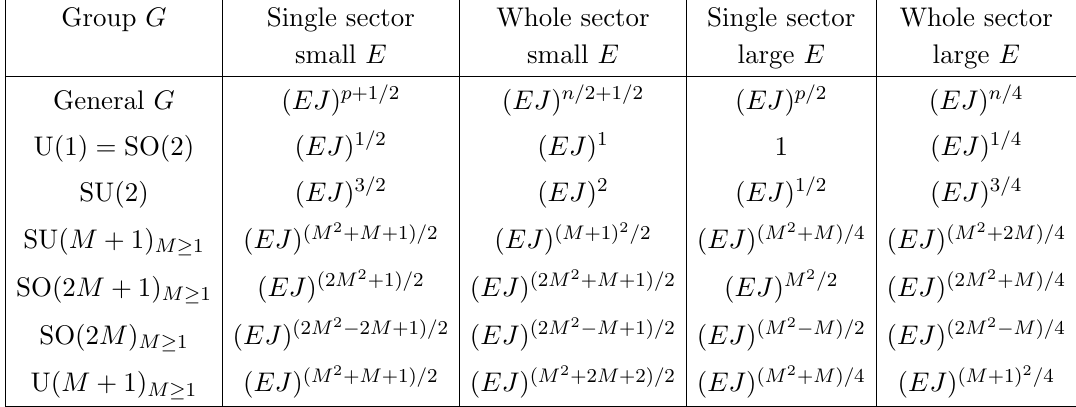
Table 2 . The density of states for Sch G